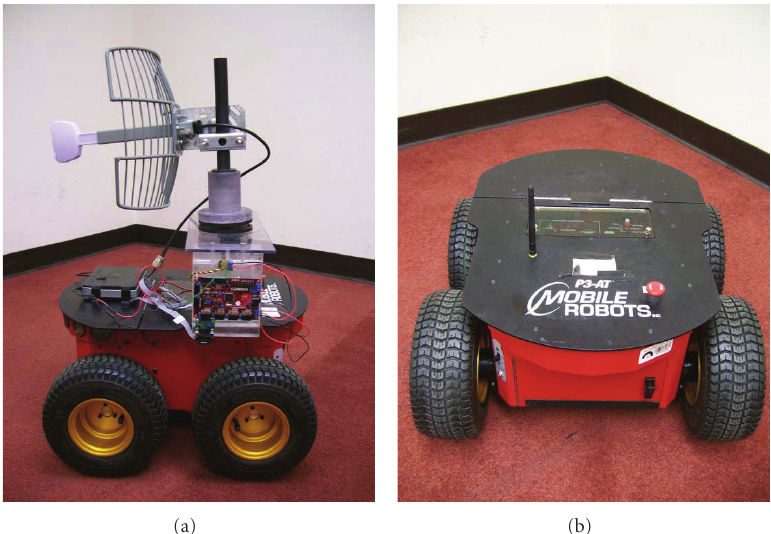
Figure 2: (a) Pioneer 3-AT robot equipped with a servomechanism and a directional antenna. (b) Pioneer 3-AT robot equipped with an omnidirectional